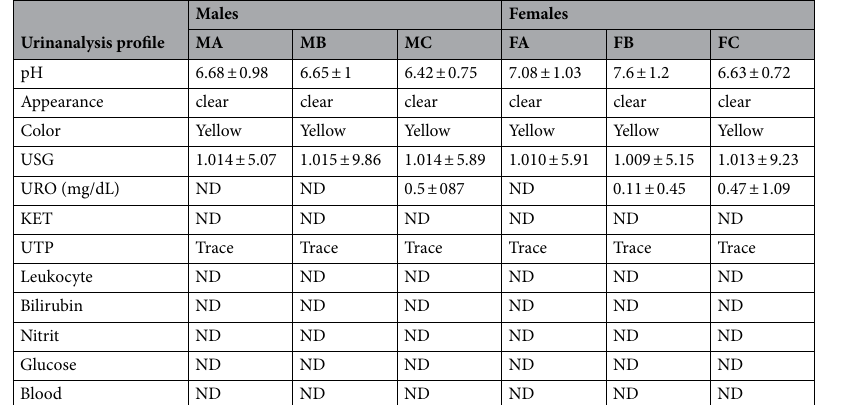
Table 5. Urinalysis- Data profile from the studied groups on the 90th day. ND = Not Detected. MA: male rats with Tarom molaii rice feeding, MB: male rats with GM Bt rice feeding, MC: male rats with standard feeding, FA: female rats with Tarom molaii rice feeding, FB: female rats with GM Bt rice feeding, FC: female rats with standard feeding. USG: urine specific gravity, URO: urobilinogen, KET: Ketones, UTP: urine total protein.